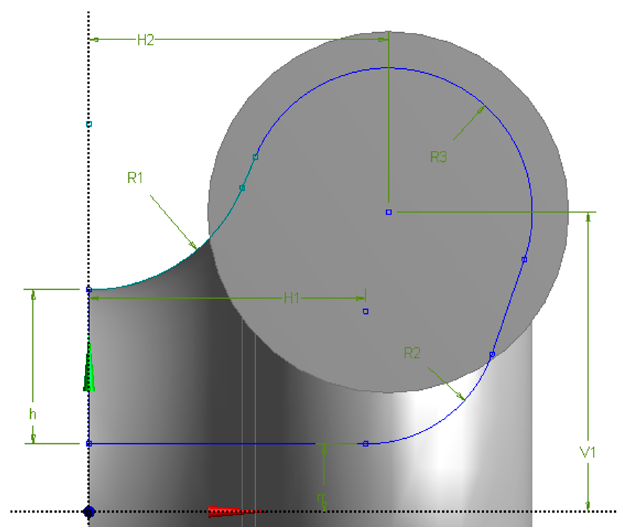
Figure 9. Third volute design.